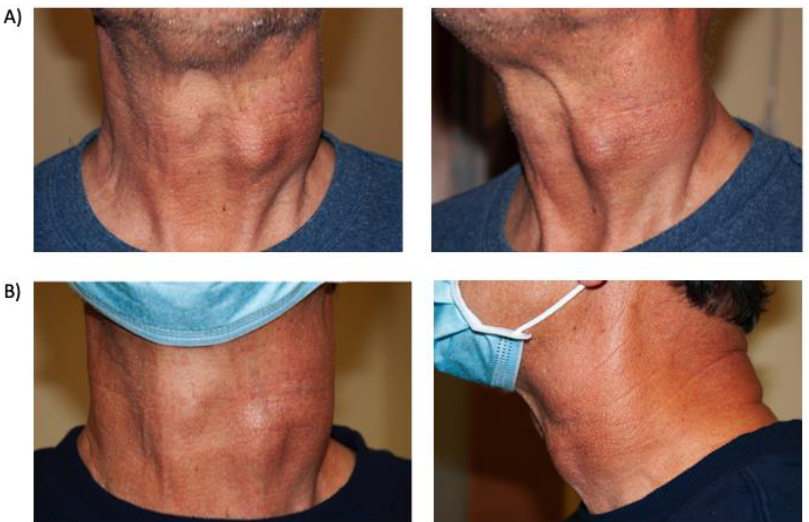
Figure 3. Case 5, ( A ) Pre-treatment anterior and lateral images of left carotid body paraganglioma; ( B ) Post-treatment anterior and lateral images of left carotid body paraganglioma for Case 5.